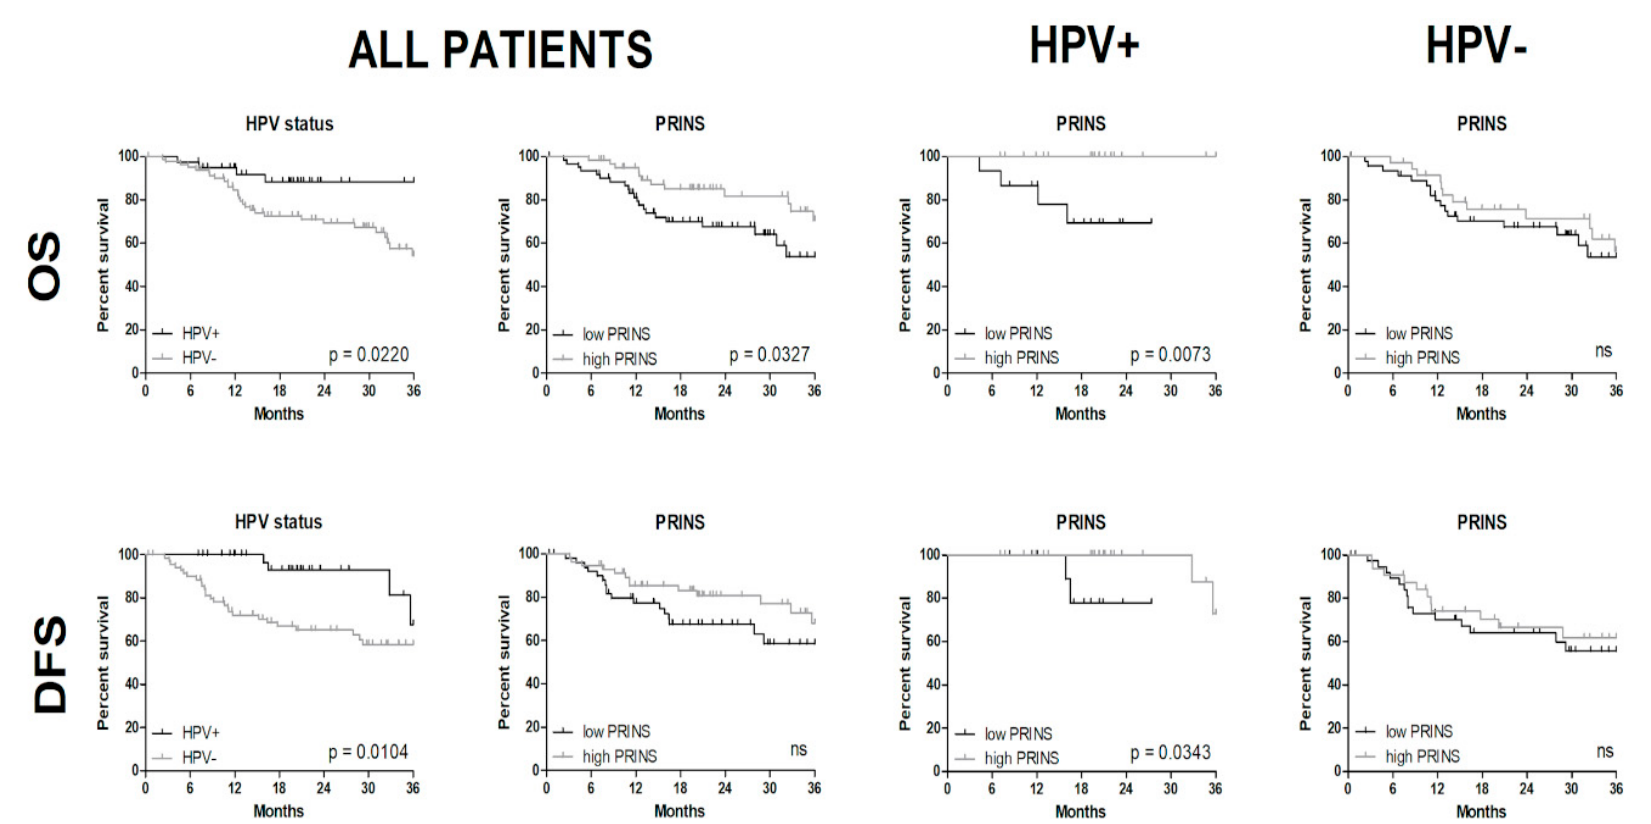
Figure 3. Overall survival (OS) and disease-free survival (DFS) of all patients grouped based on HPV status and PRINS expression as well as between HPV( + ) and HPV( − ) patients with low and high expression levels of PRINS; log-rank (Mantel-Cox) test; p < 0.05 considered as significant.